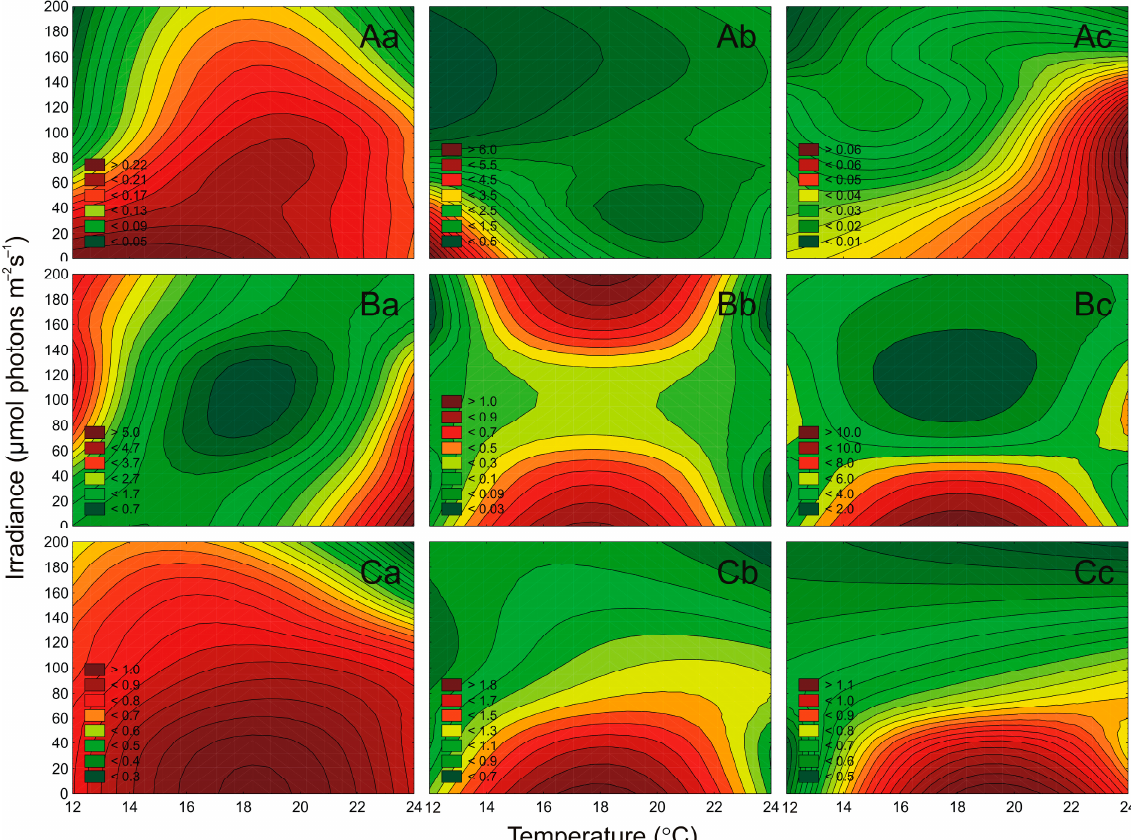
Figure 6. Changes in Car content (pg cell –1 ) obtained after 7 days of experiment for airborne cyanobacteria: Nostoc sp. ( Aa ), Synechococcus sp. ( Ab ), and Aphanothece sp. ( Ac ); airborne green algae: Oocystis sp. ( Ba ), Coccomyxa sp. ( Bb ), and Kirchneriella sp. ( Bc ); airborne diatoms: Nitzschia sp. ( Ca ), Amphora sp. ( Cb ), and Halamphora sp. ( Cc ) under different irradiance (µmol photons m –2 s –1 ) and temperature (°C) conditions.